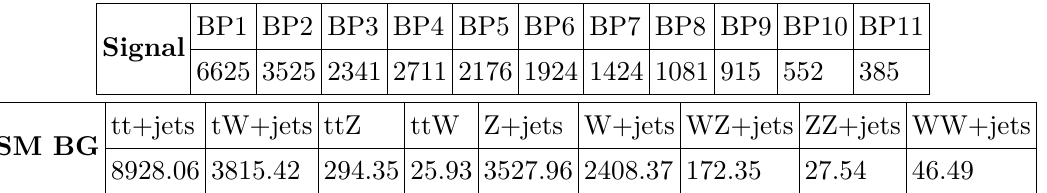
> 120 GeV, 0 > 150 GeV in addition to T